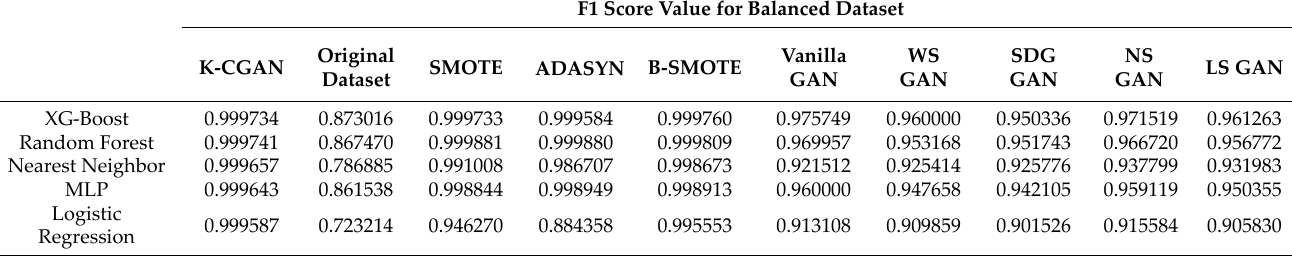
Table 10. F1 Score values for classification methods. F1 Score Value for Balanced